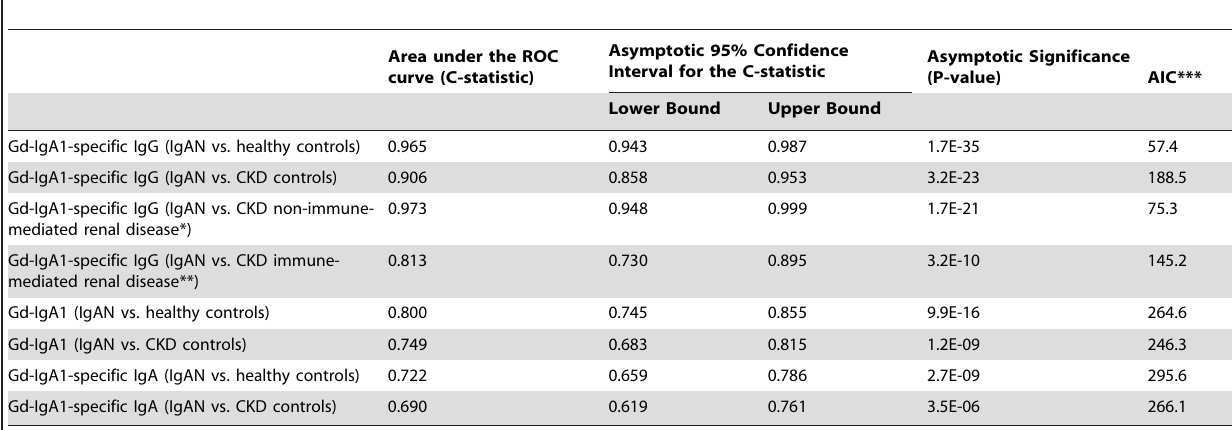
Table 4. Statistics summarized data; Discrimination between IgAN versus healthy and CKD controls for serum Gd-IgA1 and Gd- IgA1-specific IgG levels.